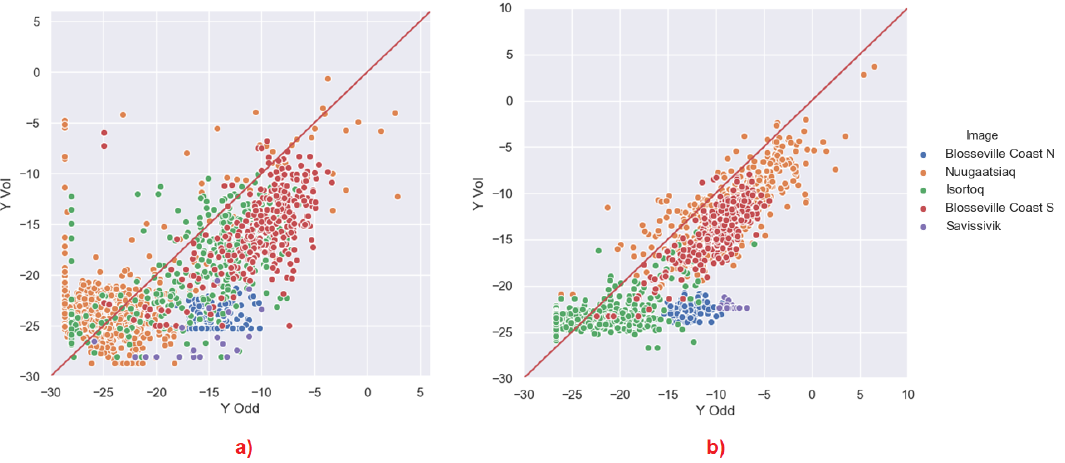
Figure 22. ( a ) Iceberg volume scattering, surface scattering plot in a 5 × 5 window, ( b ) 11 × 11 window. The majority of icebergs show surface scattering. Colour legend indicates image. Dots indicate icebergs. All values are in dB.